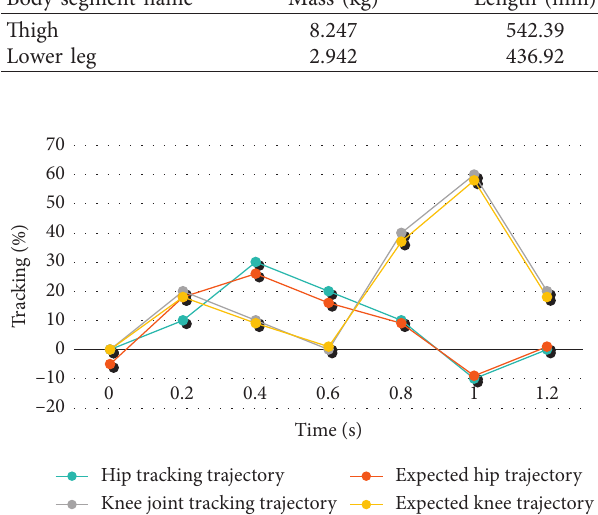
Figure 6: Trajectory tracking results based on iterative learning control.